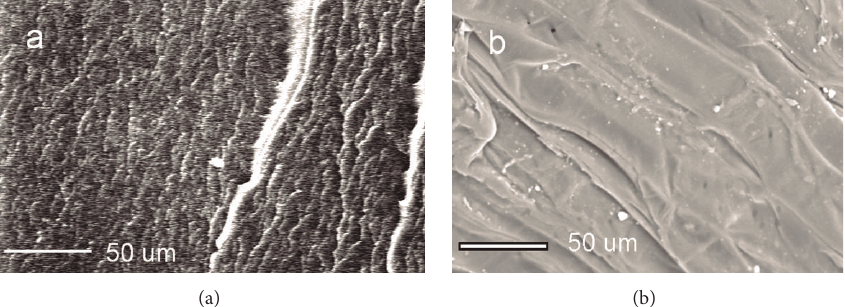
Figure 3: SEM images of irradiated (a) polyester resin matrix and (b) cellulose from Tetra Pak containers, at 200kGy.